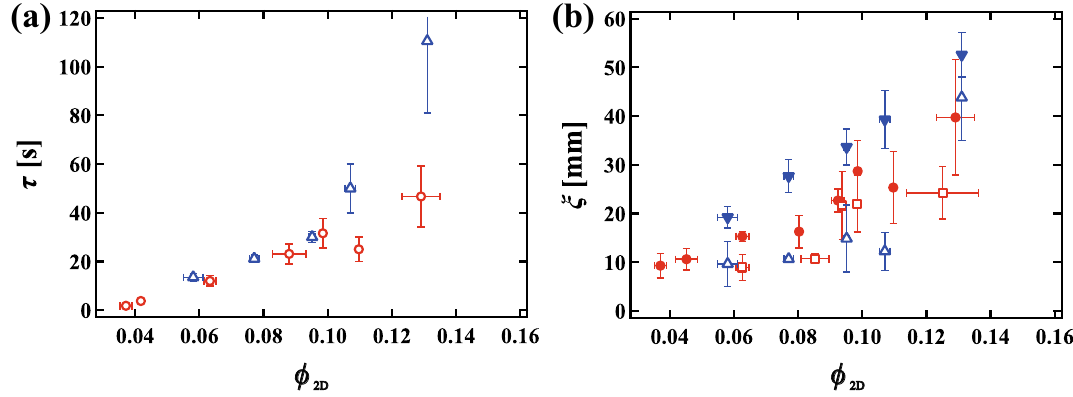
Figure 4. ( a ) The mean relaxation time τ of a single collective rearrangement event averaged over several collective rearrangements as a function of φ 2 D . Red circles and blue triangles indicate τ in monodisperse and polydisperse foams, respectively. ( b ) The mean correlation length ξ of a single collective rearrangement as a function of φ 2 D . Red filled circles and red open squares indicate ξ 1 and ξ 2 in the monodisperse foams, respectively. Blue filled reverse triangles and open triangles indicate ξ 1 and ξ 2 in the polydisperse foam. The error bars correspond to the distributions of the data.